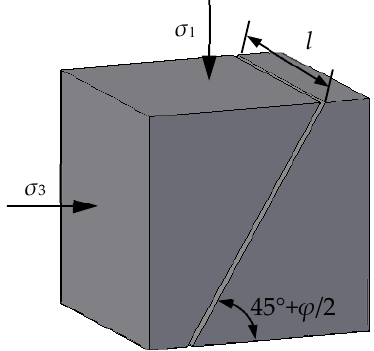
Figure 8. Calculation model diagram.